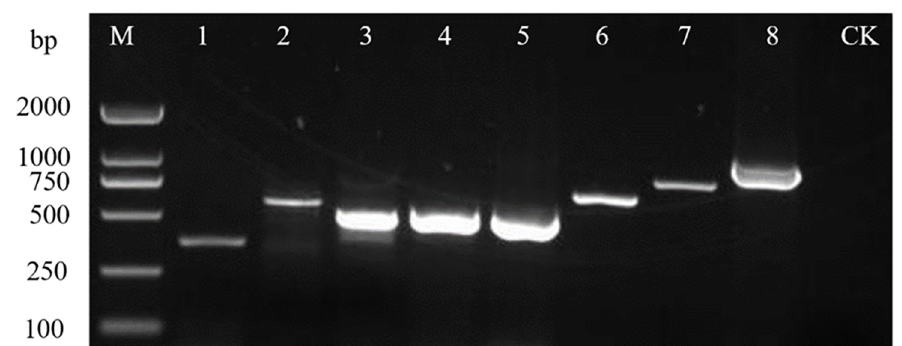
Fig 1. Electrophoresis results of virus detected in surface water. M: Trans2K 1 DNA Marker; 1–8: CMV; PMMoV; CGMMV; TMV; ToCV; ToMV; TYLCV; ToMMV; CK: Negative control.